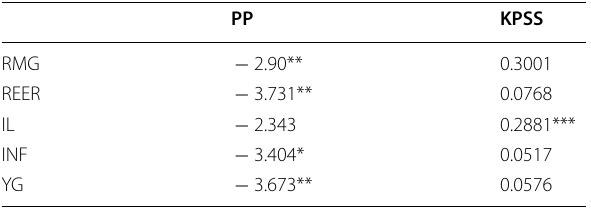
Table 2 Unit root and stationarity tests (1975–2018, including deterministic